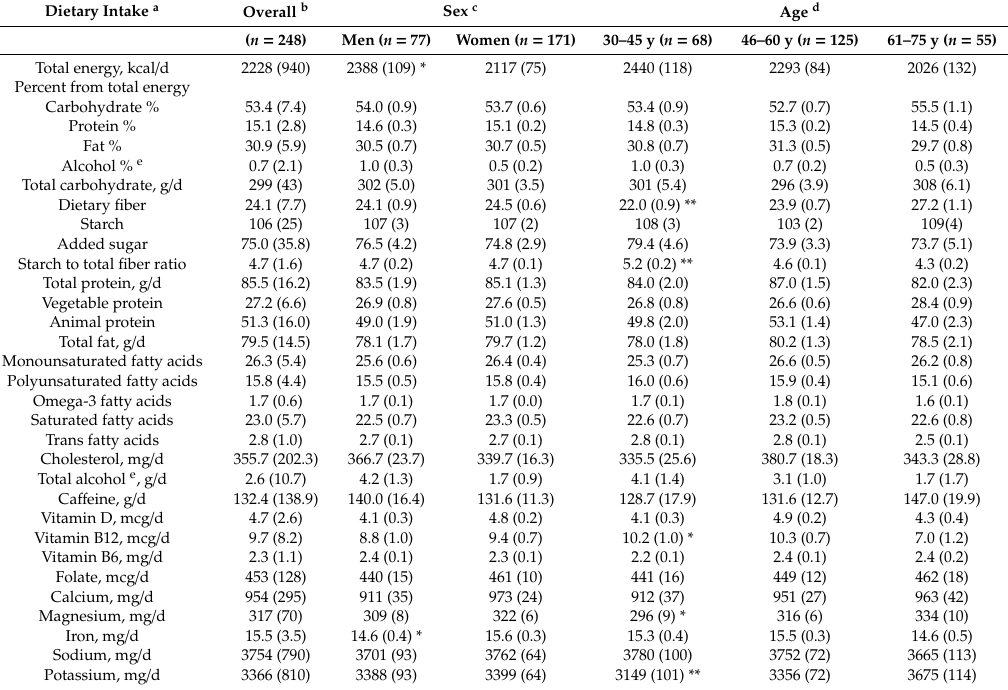
Table 1. Mean intakes of energy and nutrients of adults living in Puerto Rico, by age and sex category. Dietary Intake a